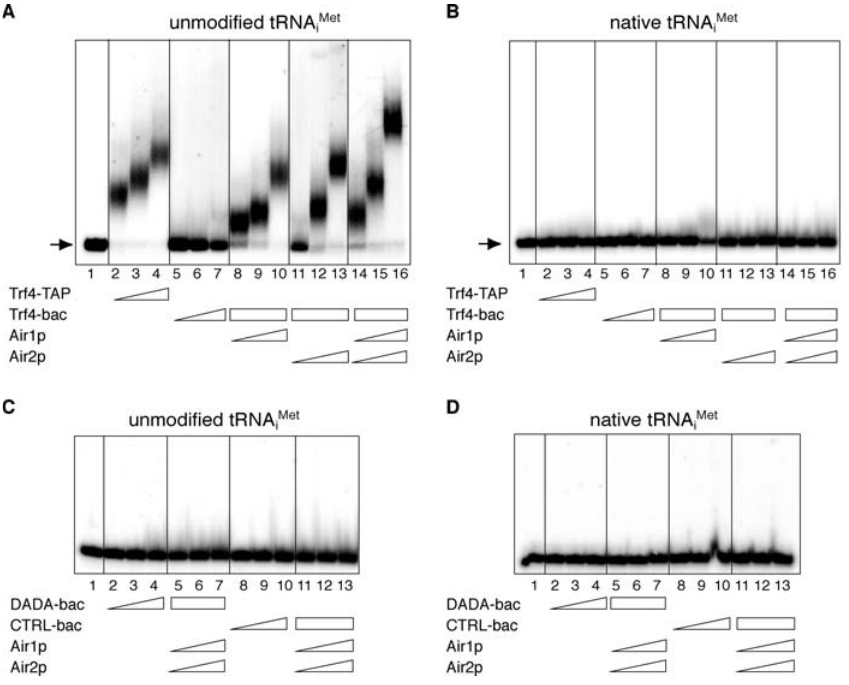
Figure 5. In Vitro Reconstitution of Trf4 Complex from Recombinant Proteins Polyadenylation assays were performed with radiolabeled unmodified (A and C) and native (B and D) tRNA iMet substrate incubated with 25, 50, or 100 ng of Trf4-TAP complex (Trf4-TAP; A and B), or with 5, 10, or 20 ng of recombinant Trf4 protein expressed in the baculovirus system (Trf4-bac; A and B), or with 5, 10, or 20 ng of mutant Trf4-bac (DADA-bac; C and D), or with equal amounts and dilutions of control eluates (CTRL-bac; proteins from cell lysates that unspecifically bound to the Ni 2 þ -NTA matrix; C and D). In reconstitution experiments 20 ng of Trf4- bac, or DADA-bac, or control eluates were mixed with 0.5, 3, or 15 ng of recombinant Air1p and/or recombinant Air2p in the combinations indicated. The proteins were pre-incubated for 30 min on ice to allow for binding. Reactions were incubated for 50 min at 30 8 C. Control reactions contained no protein (lane 1 in each gel). DOI: